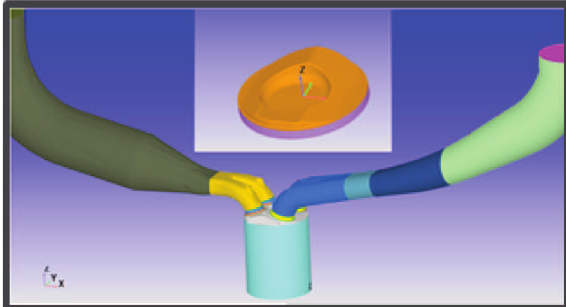
Fig. 5. Engine computational domain as visualized in CON- VERGE STUDIO and includes the piston, cylinder walls, pent roof, valves, spark plug, valve ports and runners.